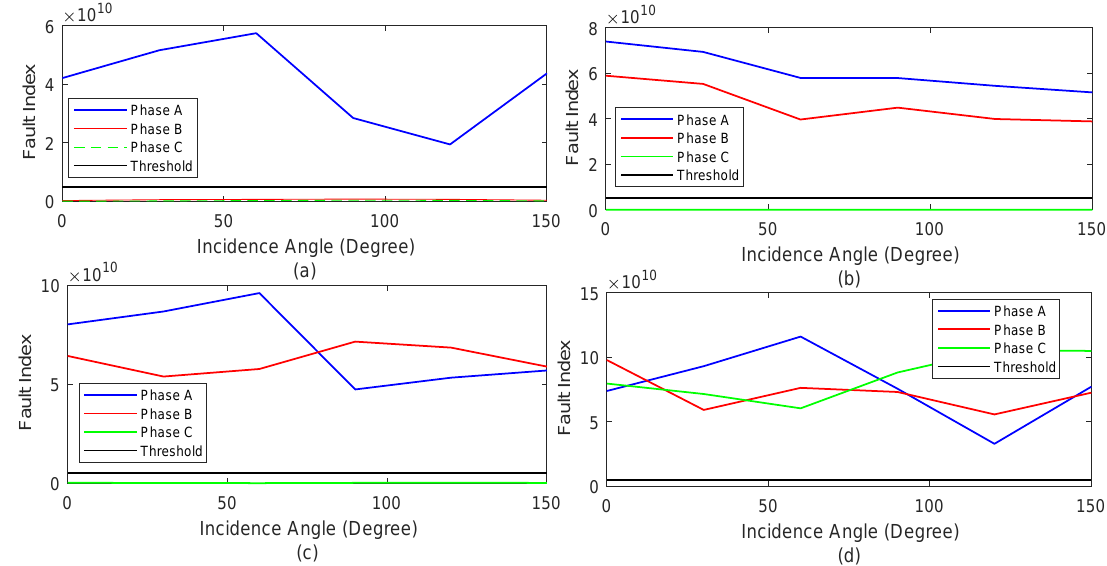
Figure 10. Effect of the varying angle of the fault incidence for detecting and classifying ( a ) L-G, ( b ) LL, ( c ) LL-G, and ( d ) LLL-G faults.